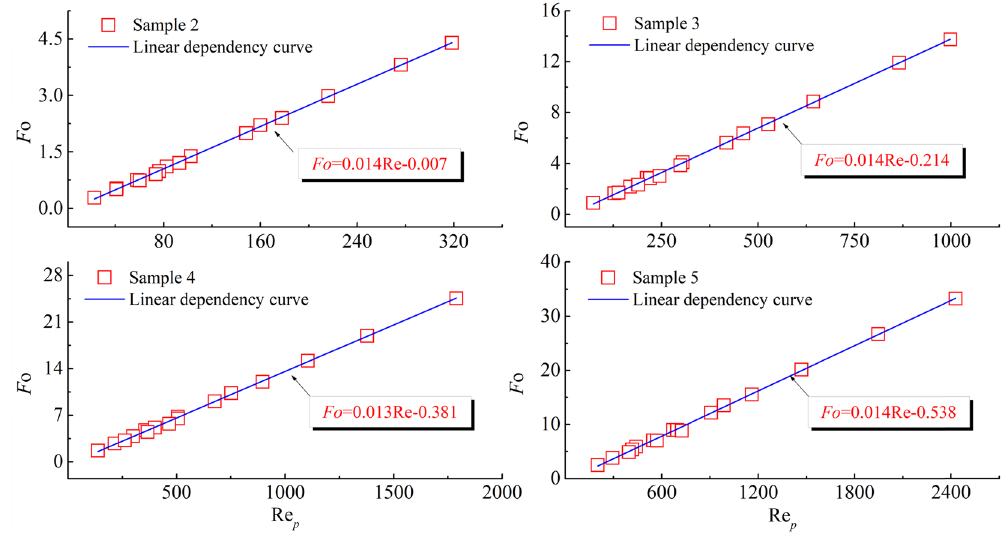
Figure 6. Relationship between Fo and Re for different